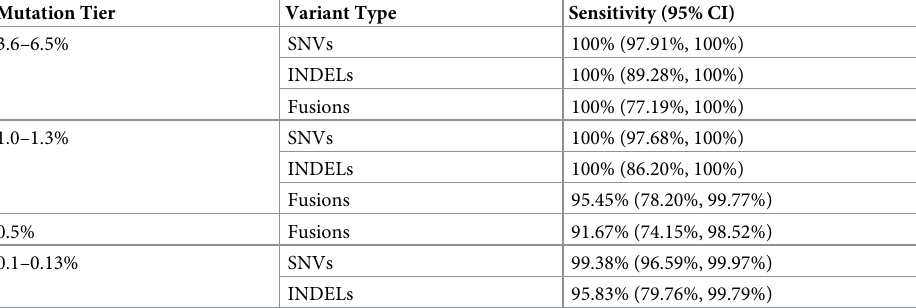
Table 1. Analytical sensitivity of the LiquidHALLMARK assay.